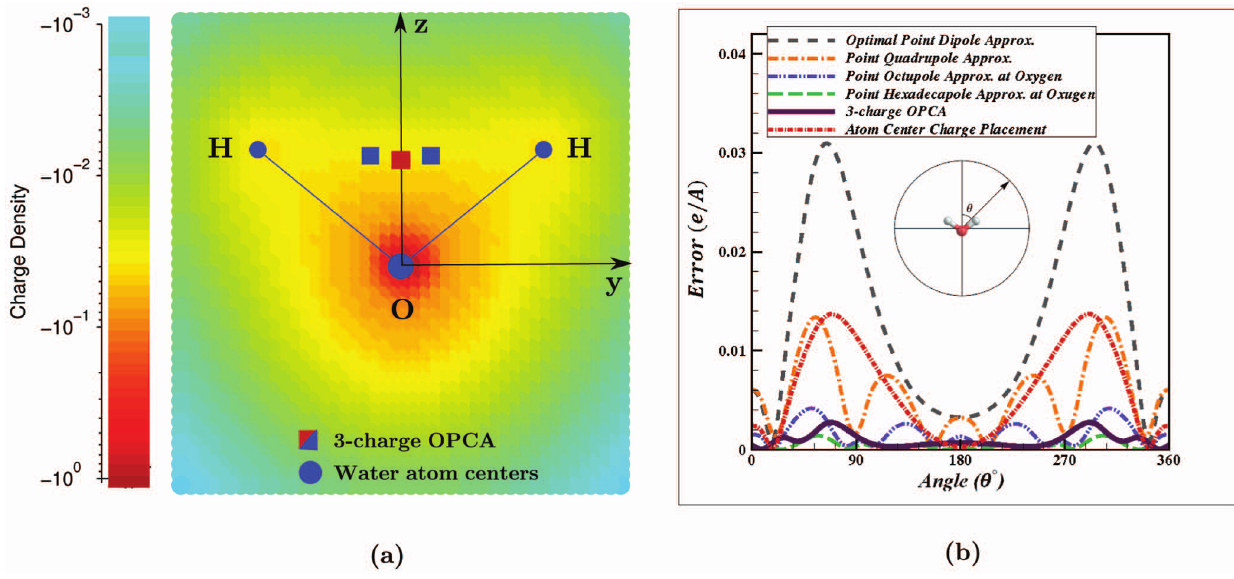
Figure 6. 3-charge optimal point charge approximation (OPCA) for water molecule. ( a ) The quantum mechanical electron charge density is visualized by a light blue to red colormap representing the charge density range of 0 to { 1 e per 0 : 05 | 0 : 05 | 0 : 05 A˚ 3 . The figure shows a 3 A˚ | 3 A˚ slice of the charge distribution in the y-z plane of the water atom centers. The origin is located at the center of the oxygen atom, the water atoms lay in the y-z plane, and the z-axis bisects the hydrogen atoms. The blue dots represent the water atom centers and the red and blue squares represent the 3 OPCA charges. The central OPCA charge has a value of { 26 e and the other two are 13 e each. ( b ) The error in electrostatic potential relative to the exact computation, calculated at 2 | R 0 ~ 2 : 8 A˚ from the oxygen atom, in the y-z plane. In this case R 0 is chosen to be 1 : 4 A˚, the mean van der Waals radius of water [42], and 2 | R 0 approximates the distance between the oxygen atoms in two closest water molecules. For comparison, we show the error for the 4 lowest point multipole approximations as well as for a commonly used approximation which places point charges on atom centers. To match the dipole moment of the original charge distribution, the charge placed at the oxygen position equals { 0 : 64 e , while the charges on the hydrogen centers are 0 : 32 e each. The same relative ordering of errors is seen in the x-z and x-y planes (not shown).